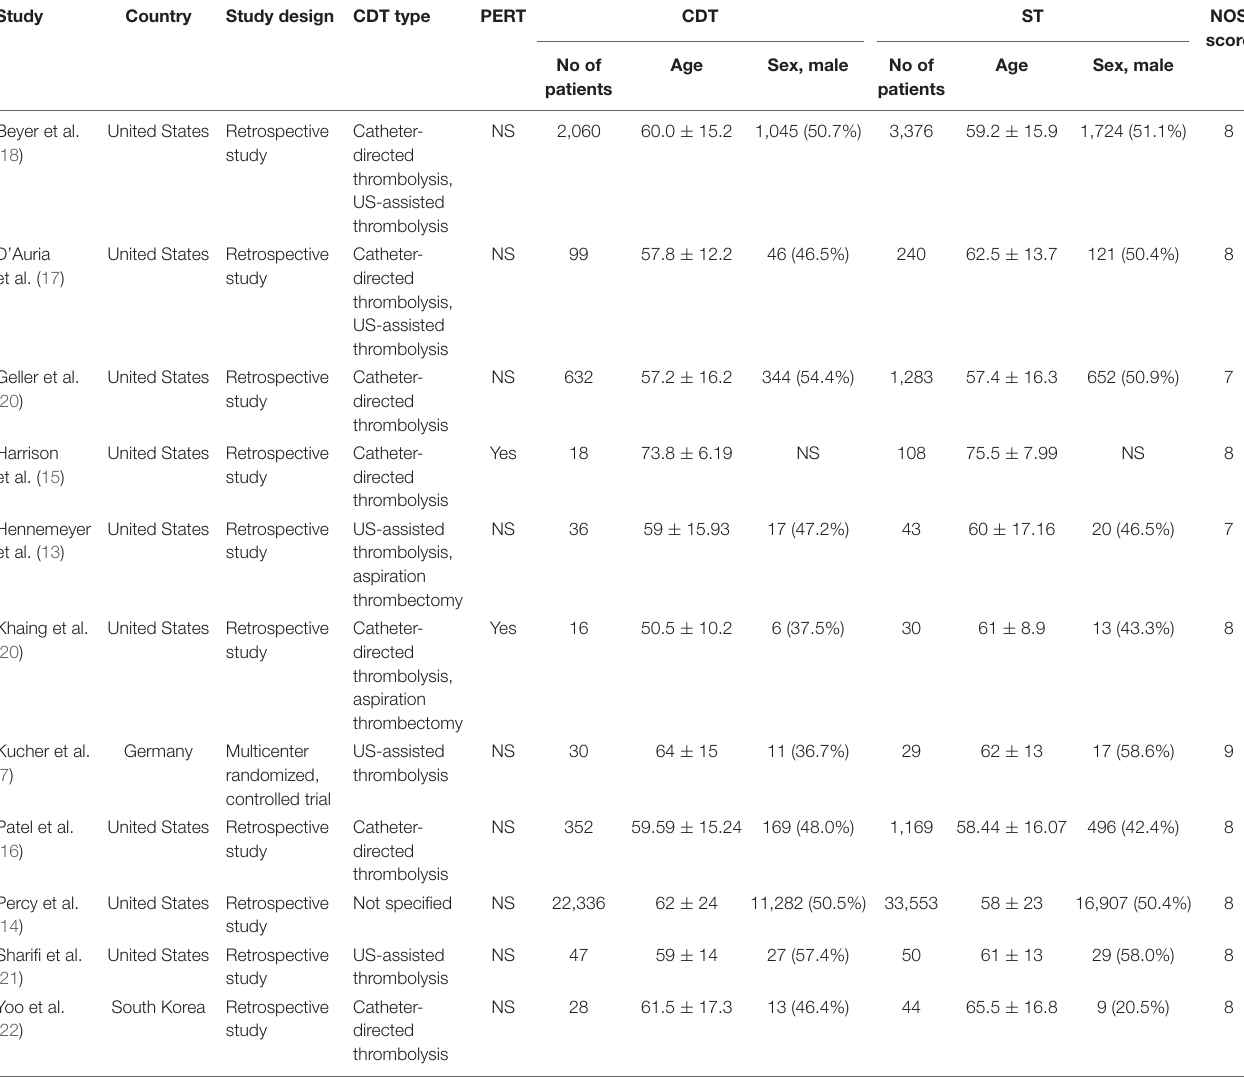
TABLE 1 | Study characteristics and patient baseline